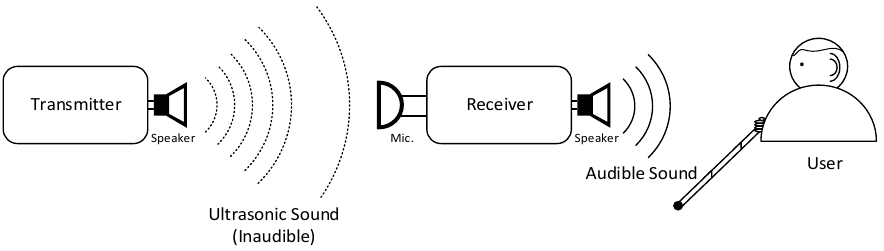
Figure 1. Schematic block diagram of the ultrasonic sound guide system for the visually